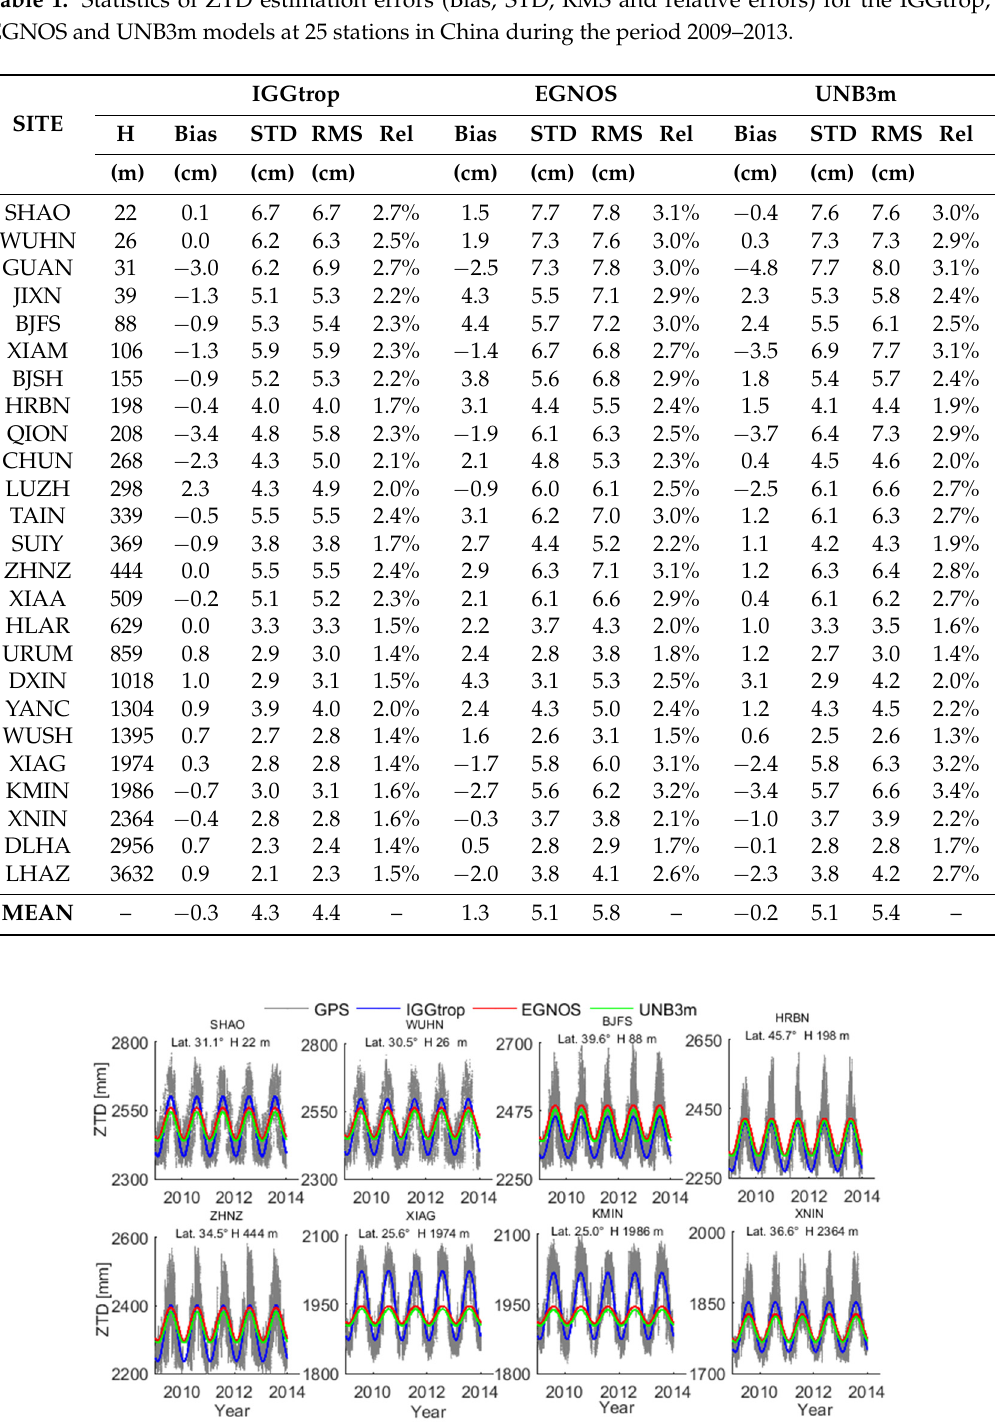
Figure 2. Time series of ZTD derived from GPS and three empirical models (IGGtrop, EGNOS and UNB3m) over the time period from 2009 to 2013.